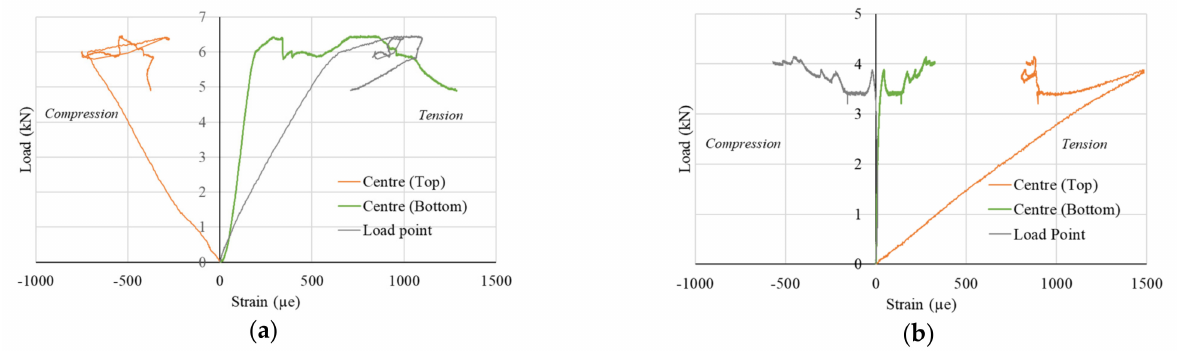
Figure 10. ( a ) Load vs. strain curves of SC-P panel. ( b ) Load vs. strain curves of SC